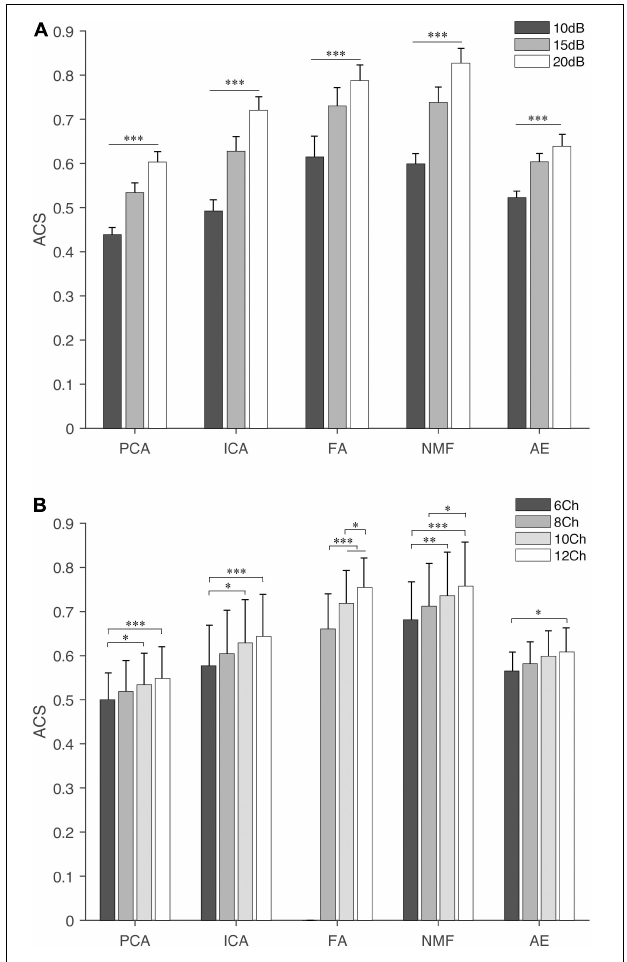
FIGURE 7 | Principal angles of extracting methods under different settings, (A) SNR and (B) NoC. The fine line on the bar is the standard error between trials. “ ∗ ”, “ ∗∗ ”, and “ ∗∗∗ ” indicate the significance levels are 0.05, 0.01, and 0.001,